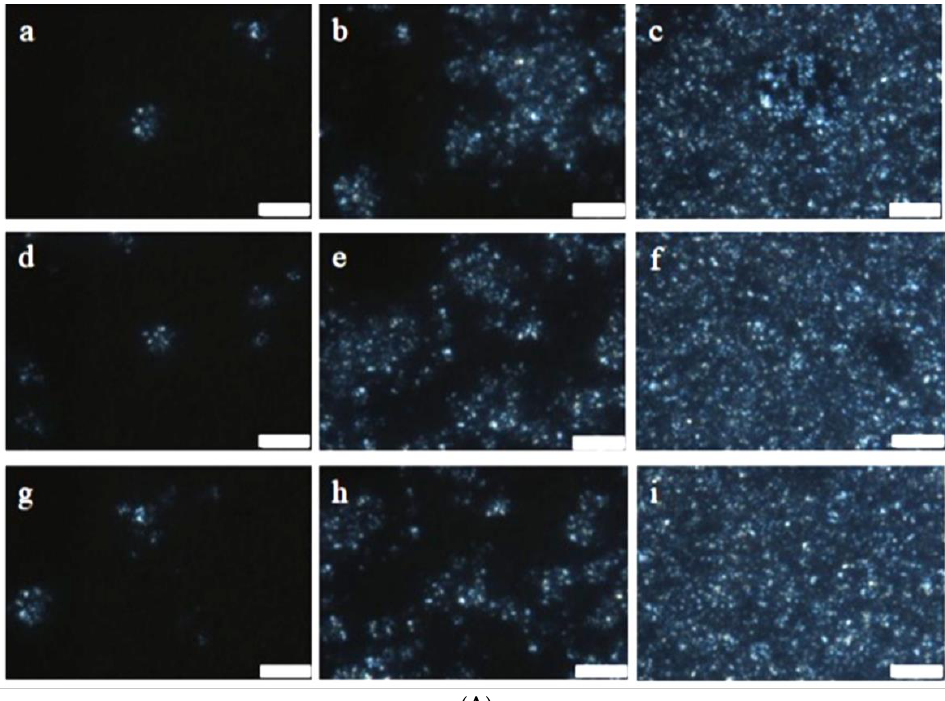
Table 4. Variation of destabilization kinetic parameters with freezing temperature for RoM and